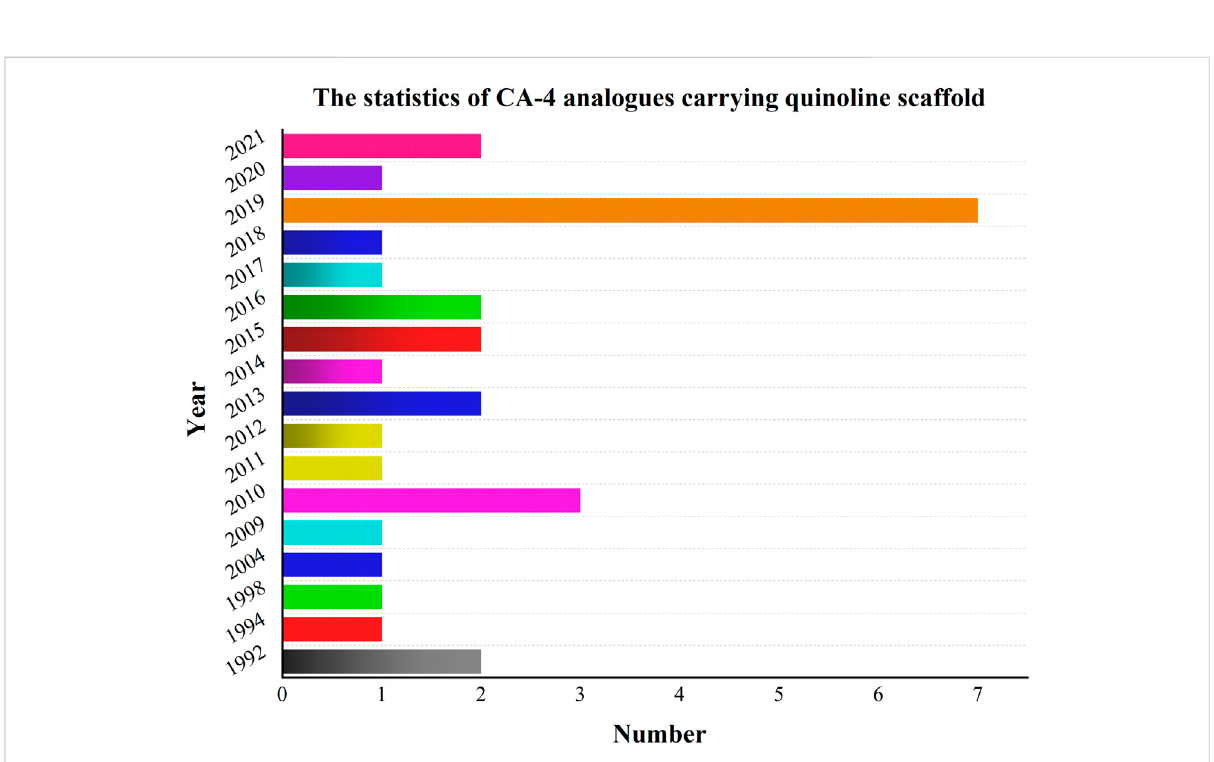
Relevant articles have been published from 1992 to